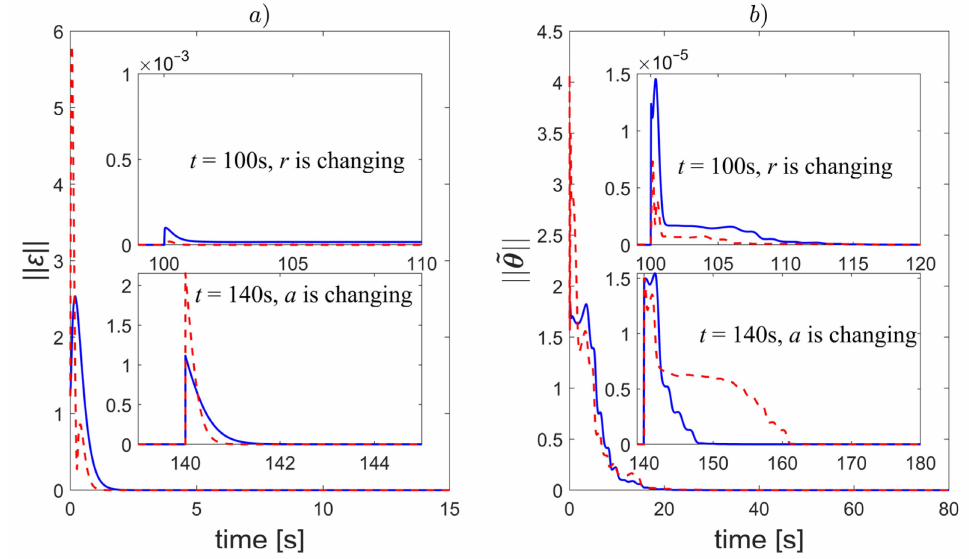
Figure 6. ( a ) Norm of the “composite” error ε ; ( b ) norm of parameter estimation errors; design param- eters: k T = [ 15 75 125 ] , providing triple eigenvalue of A 0 at − 5, Γ = diag ( 800;1600 ) , solid line; design parameters: k T = [ 30 300 1000 ] , providing triple eigenvalue of A 0 at − 10, Γ = diag ( 80 000;160 000 ) , dashed